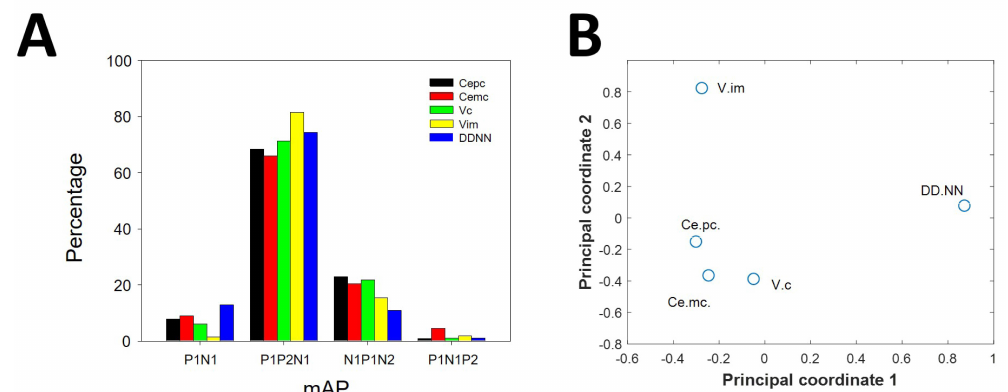
Figure 3. Distribution of mAP among nuclei. ( A ) Bar graph showing the presence of di ff erent kind of mAP for nuclei (black = Ce.pc; red = Ce.mc; green = V.c; yellow = V.im and blue = DDNN). ( B ) Multidimensional scaling analysis showing similarities between nuclei by types of mAP.